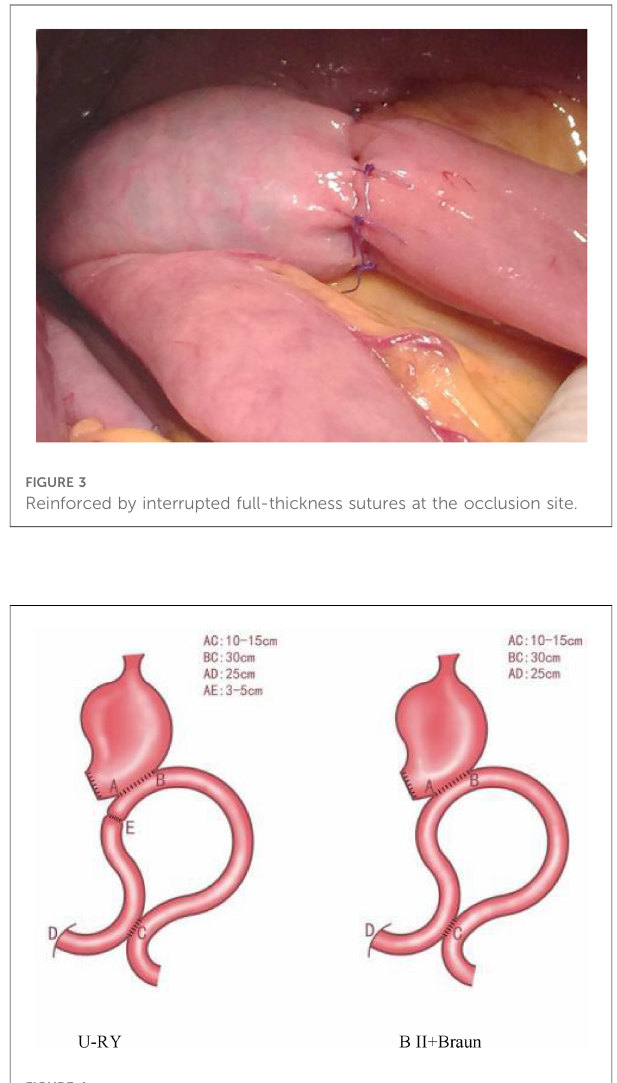
FIGURE 2 Adopt four-row staplers (knifeless) methods of jejunal